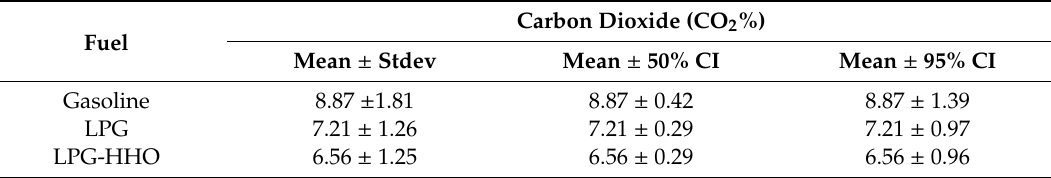
Table 4. 50% and 95% confidence intervals for mean CO 2 emissions.